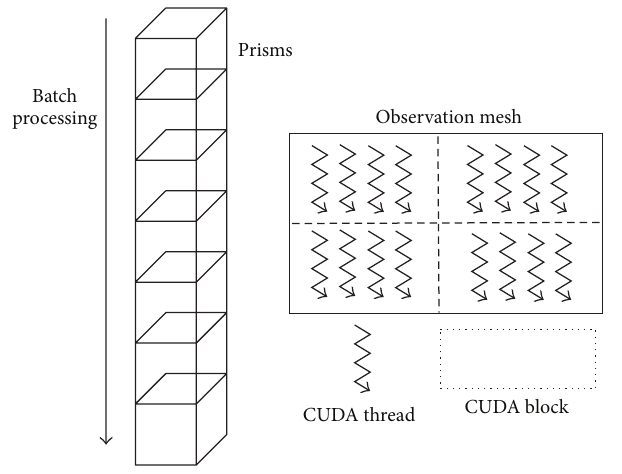
Figure 4: Partitioning by observation points.